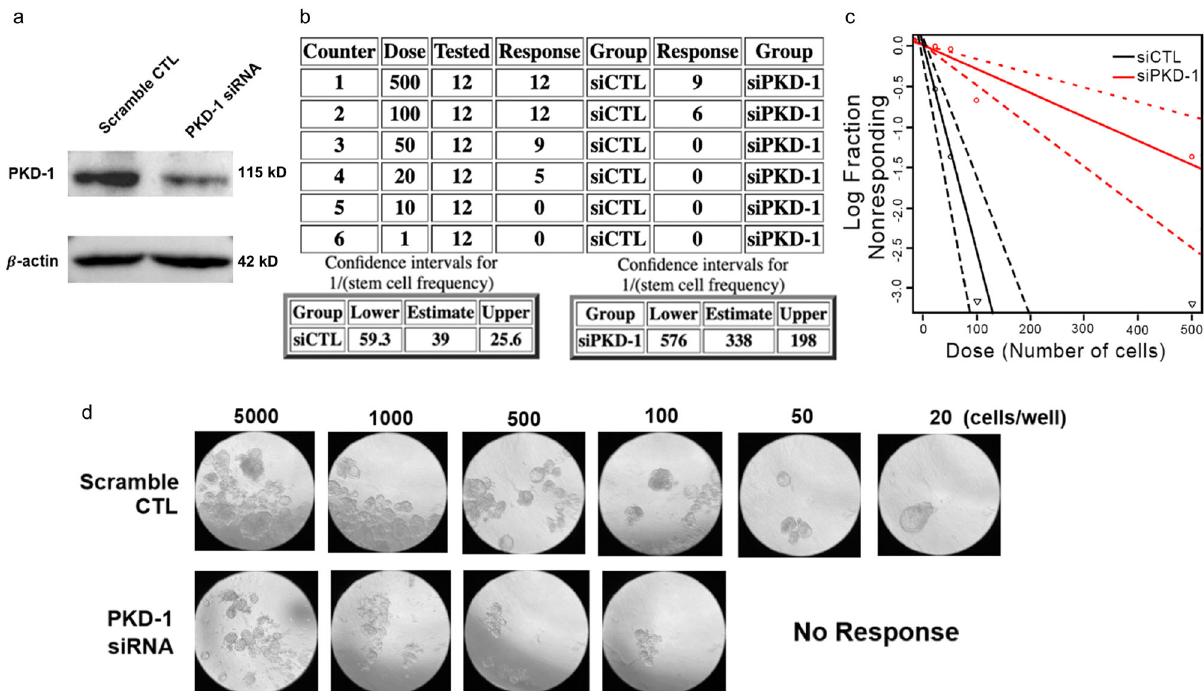
Fig. 6 PKD-1 is required for tumorigenicity by tumorsphere formation ef fi ciency assay. a Immunoblotting assay indicates that the PKD-1 expression decreased when transfecting MCF-7 with PKD-1 siRNA as compared with the scramble control (CTL). b MCF-7 with PKD-1 depletion signi fi cantly reduced tumorsphere formation ef fi ciency. c Quantitation graph shows that the number of tumorspheres formed in each well with the seeding density starting from 500 to 20 cells/well by statistical analysis. d Representative images for tumorsphere formation in MCF-7 cells subjected to siRNA scramble control (CTL) and PKD-1 siRNA and with different seeding